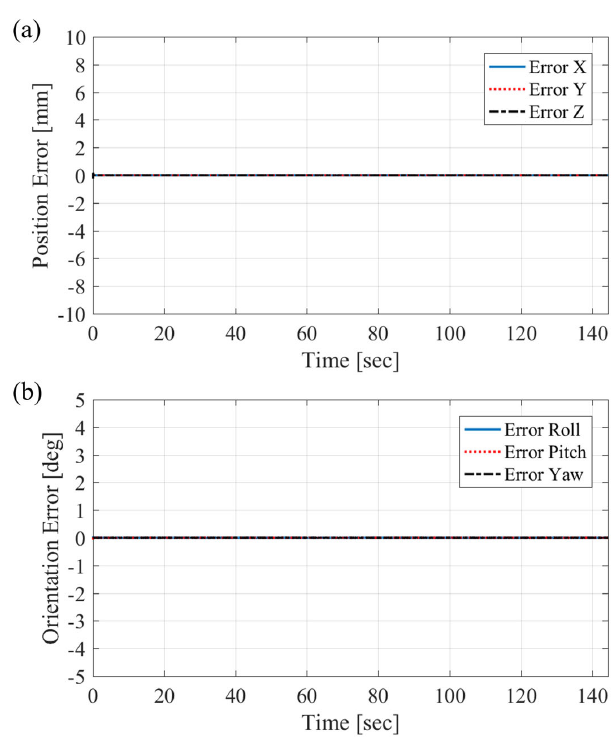
Figure 18. Error of the path generator with the Jacobian matrix and PID control algorithm: ( a ) position error and ( b ) orientation error.